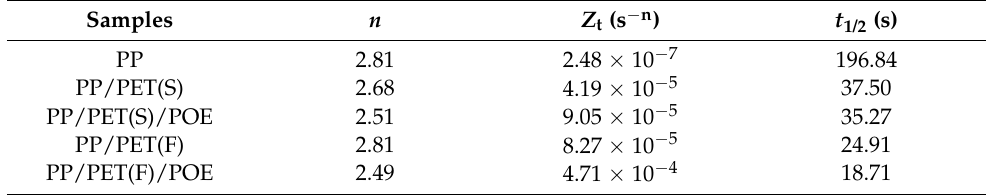
Table 2. Summary of Avrami parameters for the isothermal crystallization kinetics of samples.